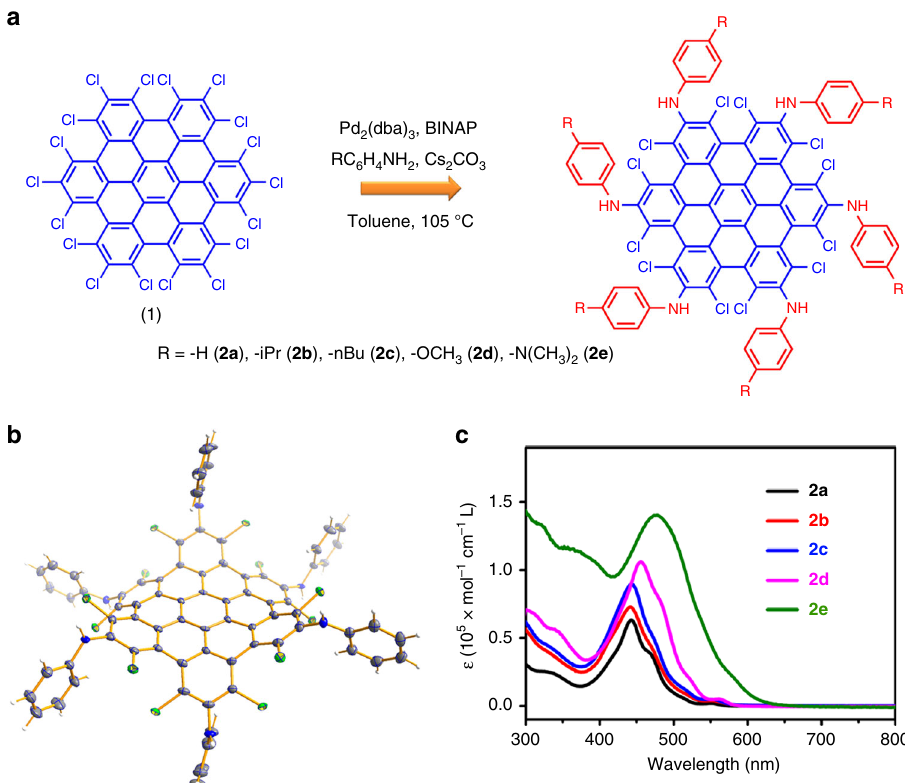
Fig. 2 Synthesis and crystal structure of 2 and optical properties. a optimized synthetic route for 2 . b the doubly concave structure of 2 represented by 2a . The thermal ellipsoids are set at 50% probability level. c UV-Vis absorption spectra of 2 measured in dichloromethane (the concentration of 2 is 10 − 5